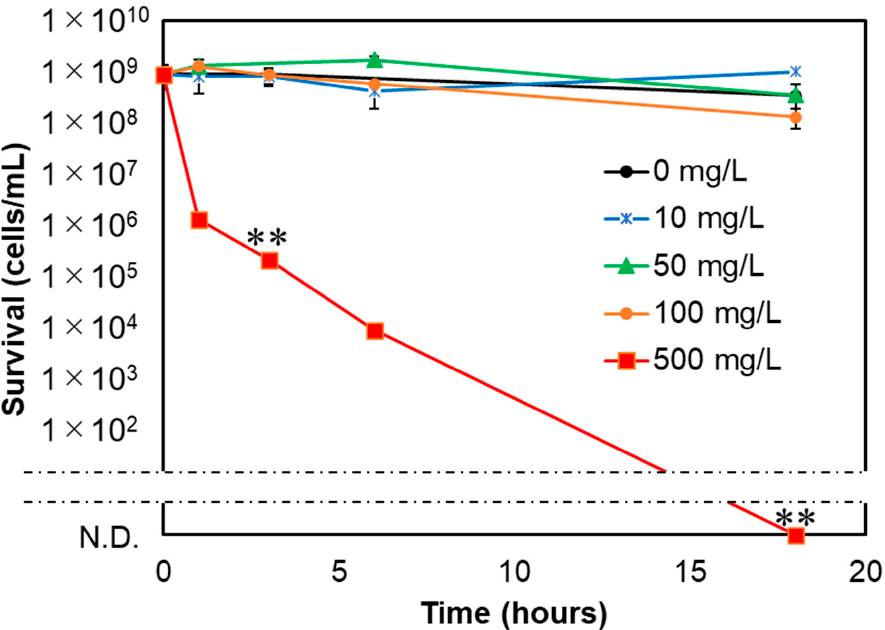
Figure 2. Bactericidal effect of NM80 at concentration dependence. Different concentrations of NM80 at 500 mg/L (red), 100 mg/L (orange), 50 mg/L (green), and 10 mg/L (blue) mg/L were examined to assess the ability of NM80 to eliminate E. coli . N.D. means “not detected,” i.e., completely sterilized. Student’s t -tests were used to compare the bactericidal effects of different NM80 concentrations relative to 0 mg/L NM80 (** indicates a p -value < 0.01).